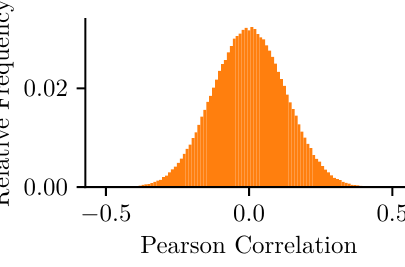
Figure 4: The distribution of the pair-wise Pearson correlation coefficient for 1000 vectors of 64 i.i.d. normal distributed elements, which represent random APUF instances.